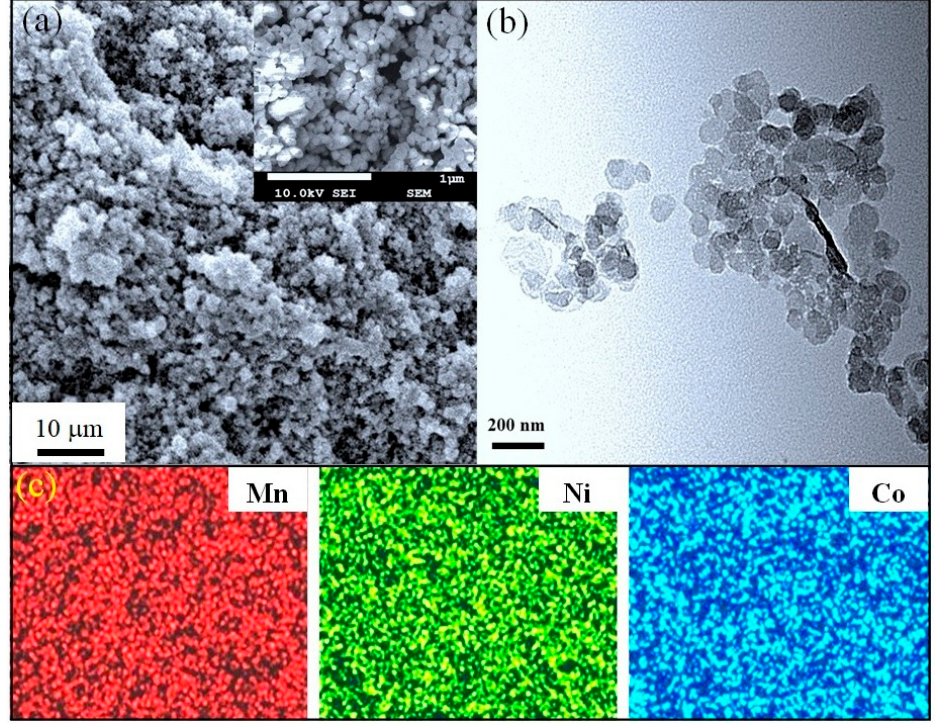
Figure 5. ( a ) FE-SEM, ( b ) TEM and ( c ) EDS mapping (Mn, Ni, and Co) images of the powder calcined at 650 ◦ C. Inset in ( a ): magnified FE-SEM image shows quite uniform particles with a spherical